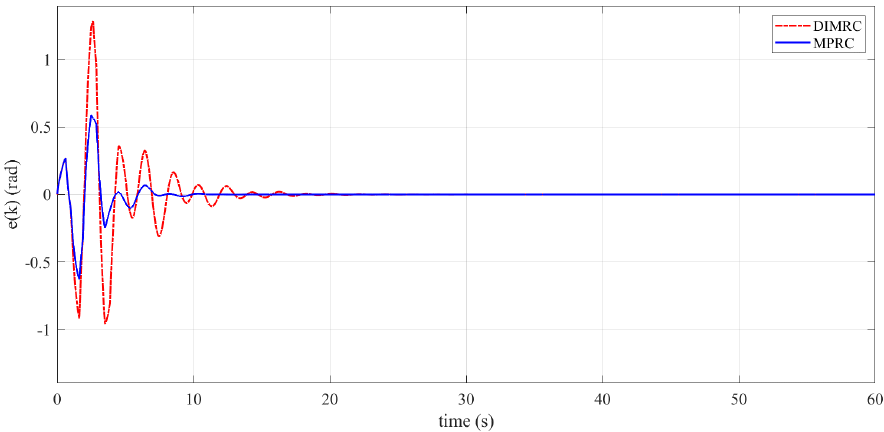
Figure 11. Tracking errors for the non-minimum phase system (42) with the disturbance model v 1 ( t )